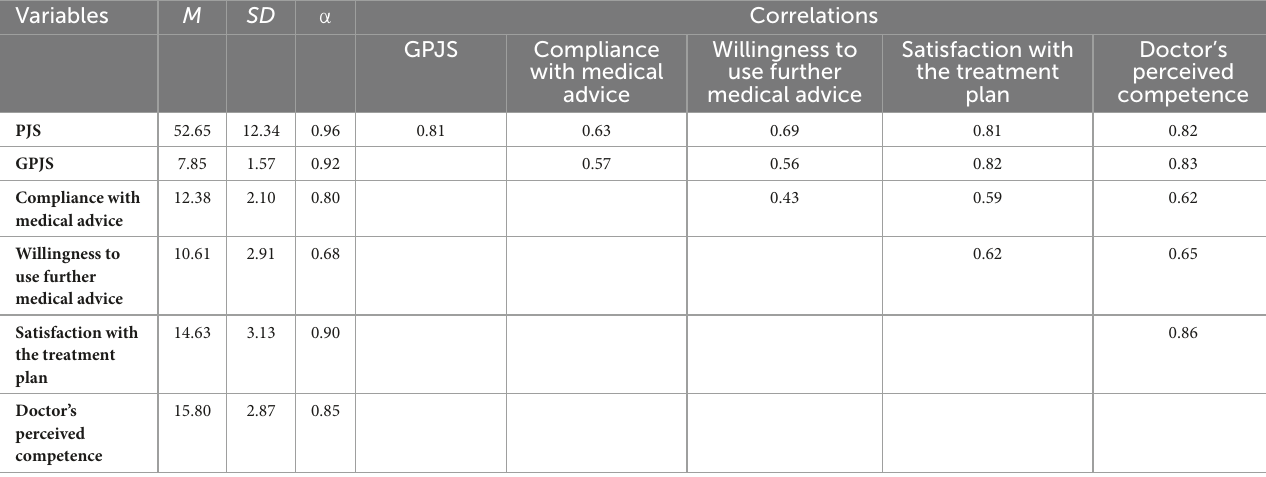
TABLE 1 Descriptive statistics for the analyzed variables, reliability values for measurement scales, and correlations between variables. Variables